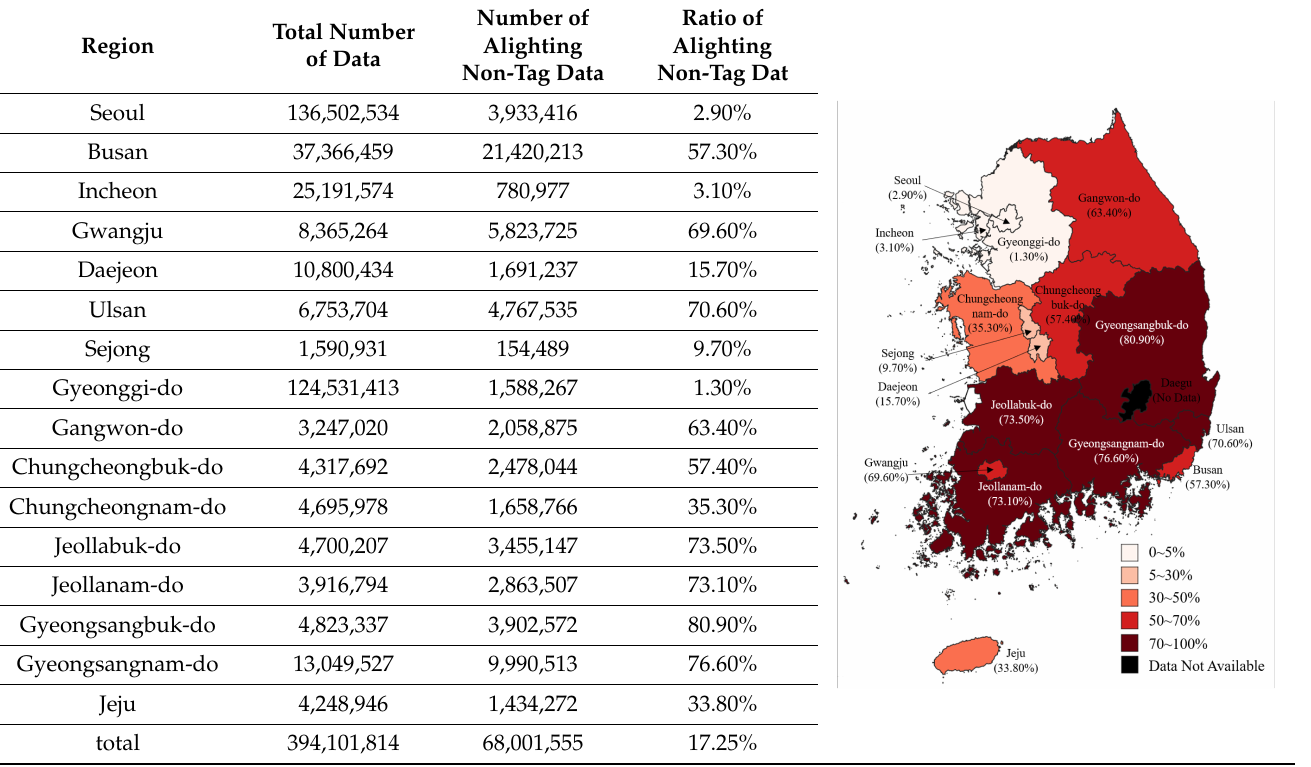
Table 2. Result of analysis on the status of alighting non-tag by city and province based on traffic card data (April 2020).